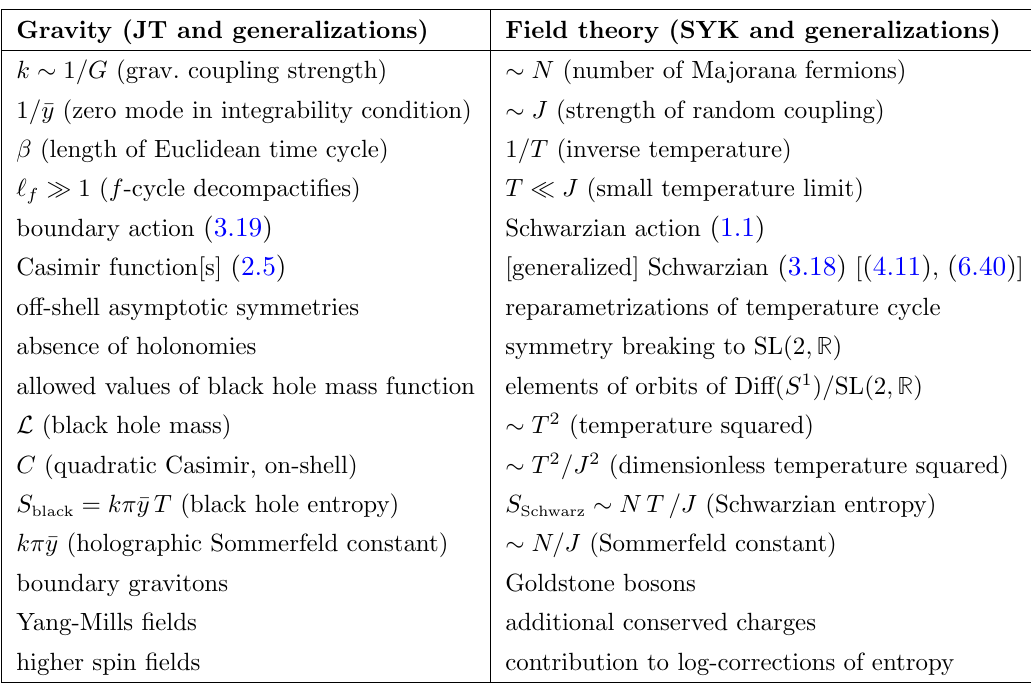
Table 1 . Generalized SYK/JT